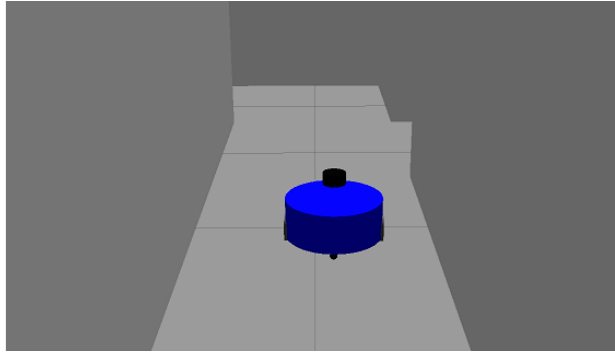
Figure 25. The robot performs the navigation task in the maze.